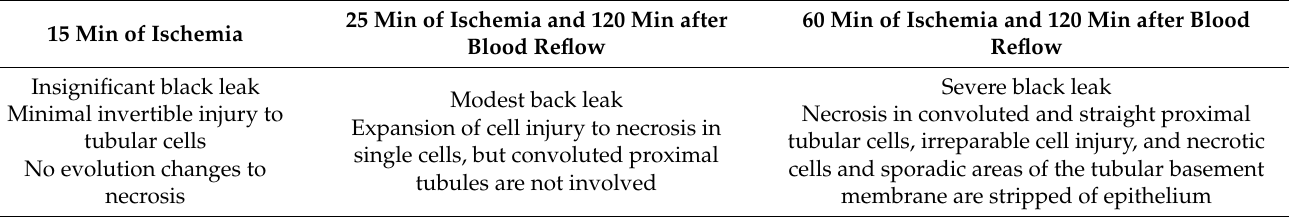
Table 1. Morphological alterations in the kidneys, depending on the time of